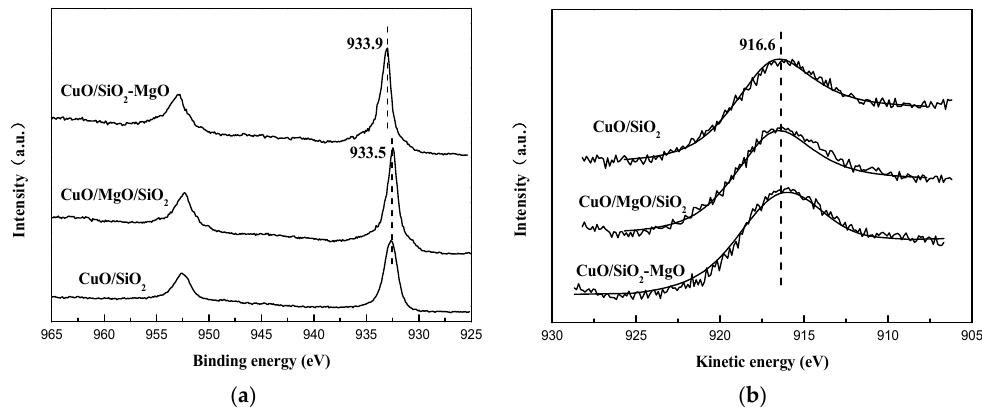
Figure 14. XPS spectra ( a ) and LMM XAES spectra ( b ) of the catalysts after reaction after reaction. CO-IR is an appropriate measure for characterization of Cu + sites, where molecular CO can be strongly adsorbed to form carbonyls. As presented in Figure 15a, only one peak at 2120 cm − 1 was observed in the IR-spectra of each catalyst, which was ascribed to the linear adsorption of CO molecules on the Cu + sites according to the Cu n+ -CO system detailed by the previous literature [55–59]. Moreover, according to the semi-quantity method for the amounts of Cu 1+ by Xue et al. [60], we calculated the integration area of the Cu 1+ -CO band and the results are listed in Table 1. The amount of Cu + follow the order as CuO/SiO 2 -MgO > CuO/SiO 2 > CuO/MgO/SiO 2 , which is consistent with the dispersion of CuO on the various supports. Figure 15b displayed the relationship between the amount of Cu + species of each catalysts and the corresponding BD yield. With the increasing amounts of Cu + species, the activity first decreased and then increased. In general, the high amount of Cu + exposed on the catalyst surface were favorable for the ethynylation reaction [11,12]. However, Cu + species was minimal on the Cu/MgO/SiO 2 catalysts, the catalytic activity over Cu/MgO/SiO 2 catalysts is much higher than Cu/SiO 2 . This results triggered us to consider the other factors that affect the activity of the catalysts, which will be discussed in the next section.